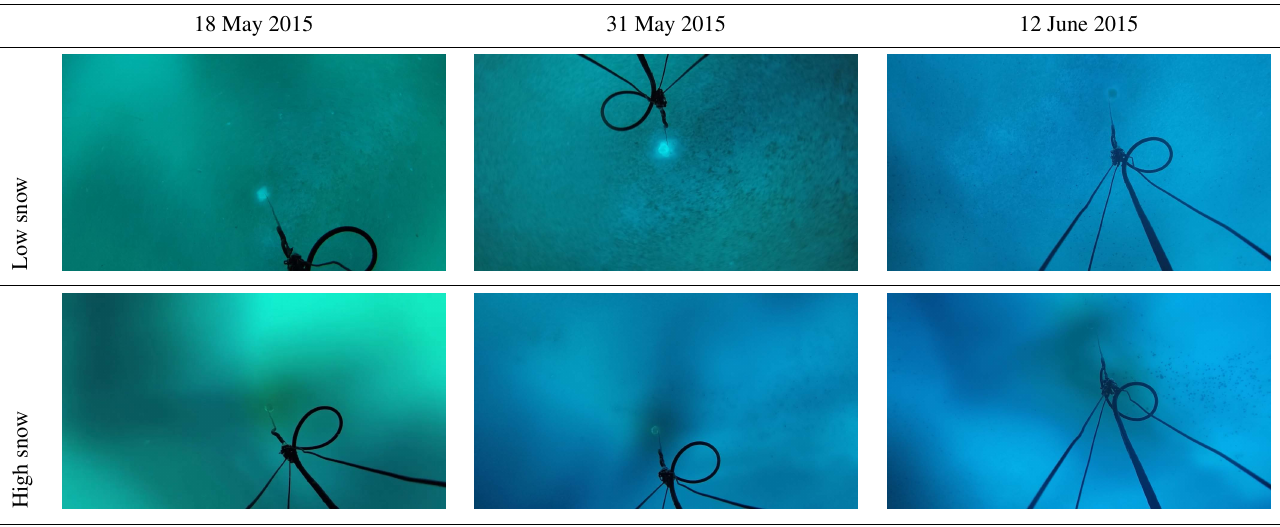
Table B1. Examples of GoPro Hero 4 photos at the low and high snow holes in 2015 demonstrating the spatial variability of the ice bottom across time and